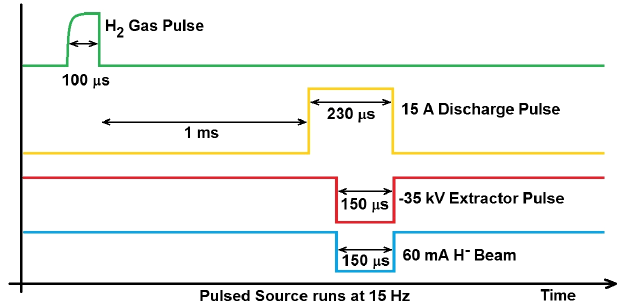
FIG. 2. Linac beam pulse (top) at a 5 μ s = div scale with visible 50 to 100 ns microstructures at a shorter scale of 200 ns = div (bottom). Vertical scales are 500 mV = div.